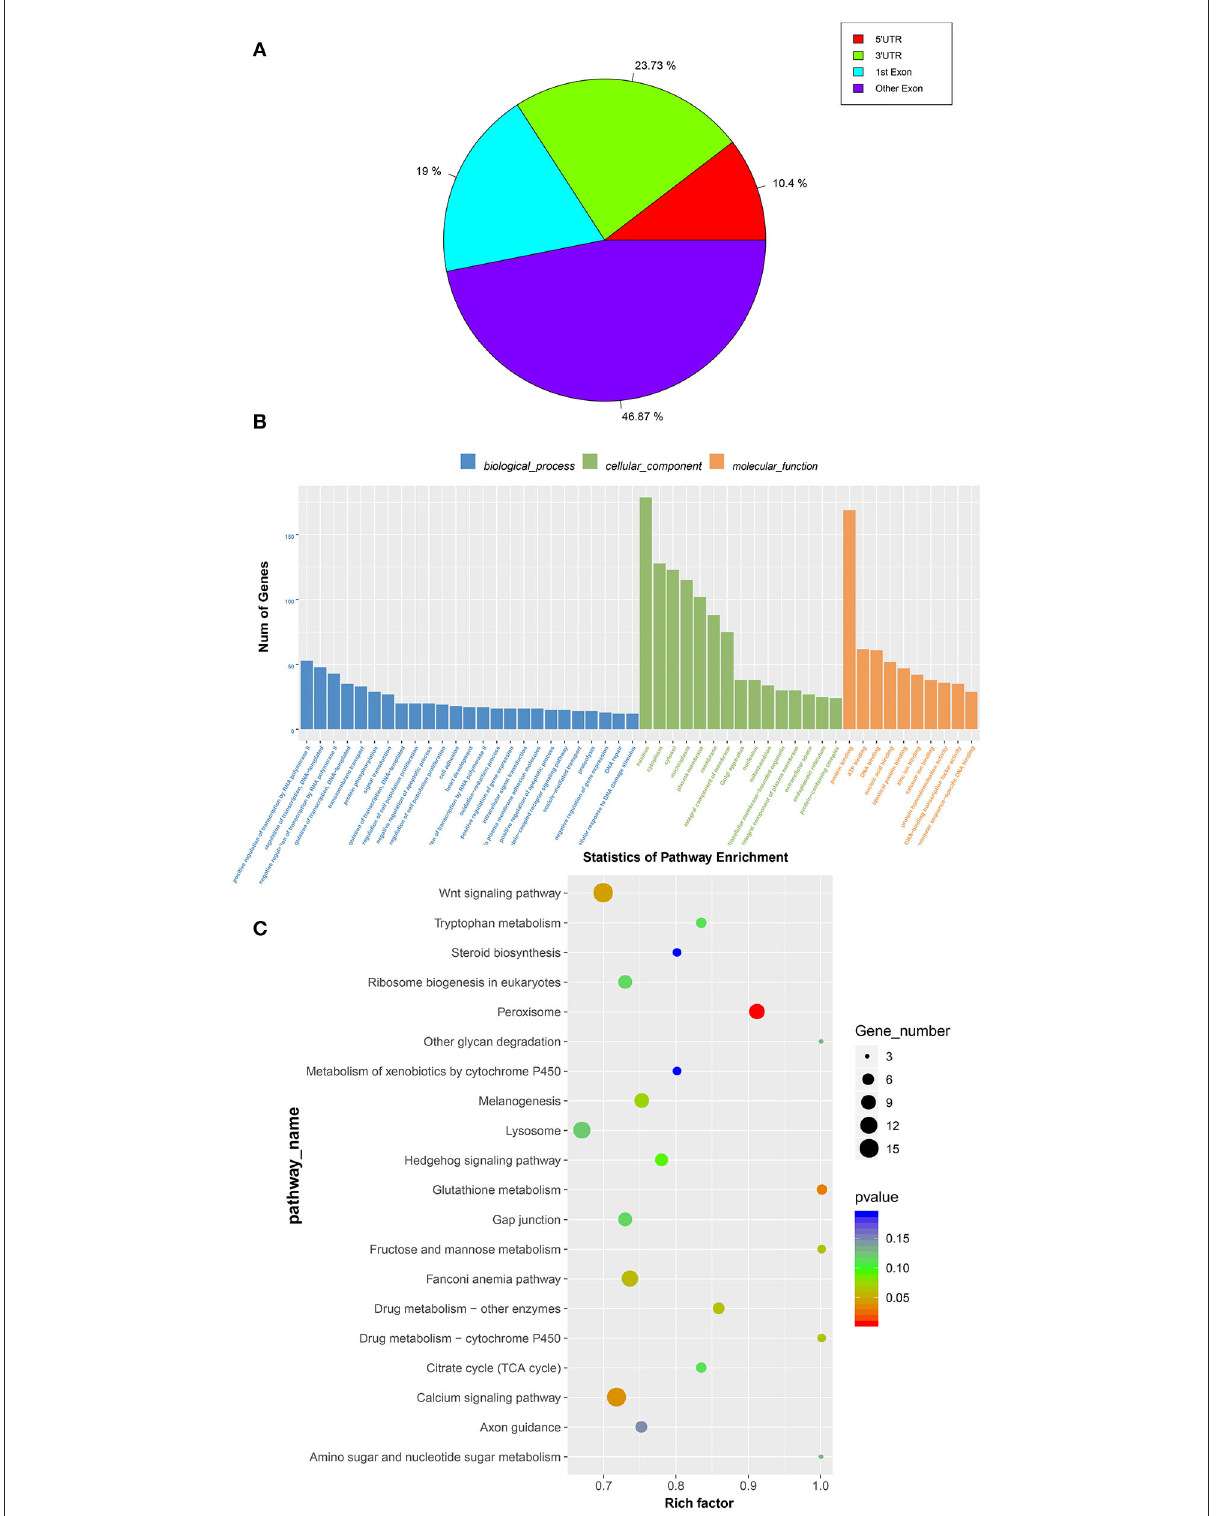
FIGURE3 GO and KEGG analyses of m6A-modified genes. (A) Distribution of m6A-modified genes (MMGs) along genes. (B) Analysis of GO enrichment. (C) Statistics of KEGG pathway